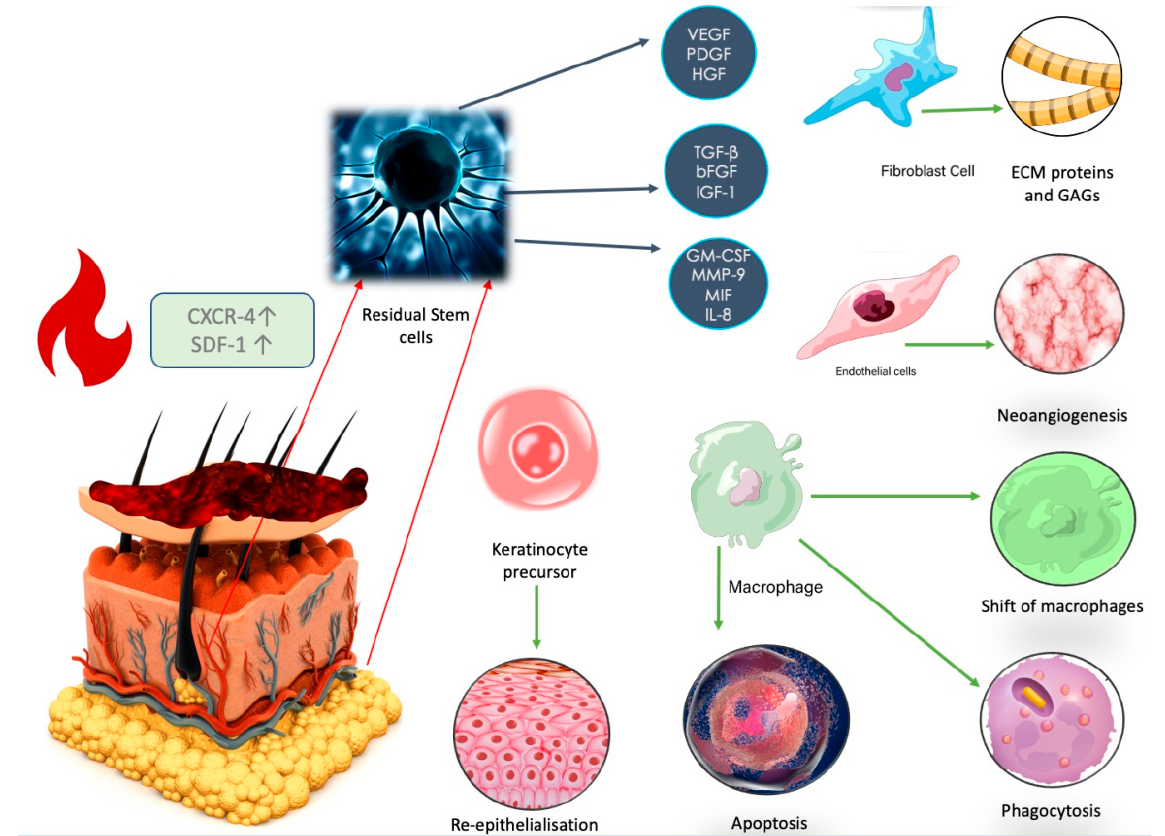
Figure 3. After trauma, expression of the CXCR-4 increases, and residual fat-derived stem cells from the area of the hair follicles, sweat glands, and nerve endings are recruited to regulate the local inflammatory response. Overexpression of the SDF-1 protein is responsible for cell migration in the early stages of wound healing. ADSCs promote the shift of the macrophage population from M1 to M2 and stimulate the secretion of anti-inflammatory TNF and IL-10. Images purchased under the Adobe Stock License.